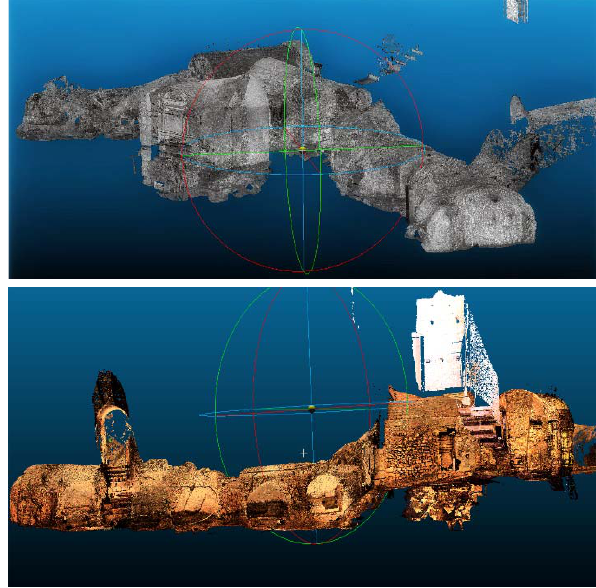
Figure 5. Cloud Compare meshing workflow from Laser scanner cloud points, Poisson Surface Reconstruction.